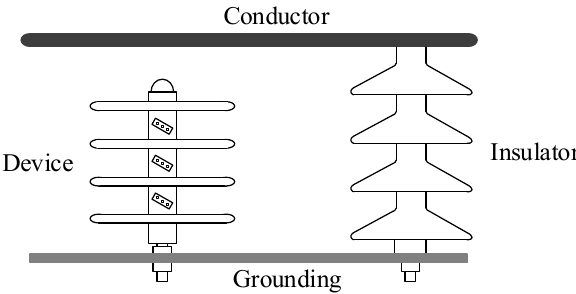
Figure 1. Schematic diagram of air ‐ blown interrupter gap installation.